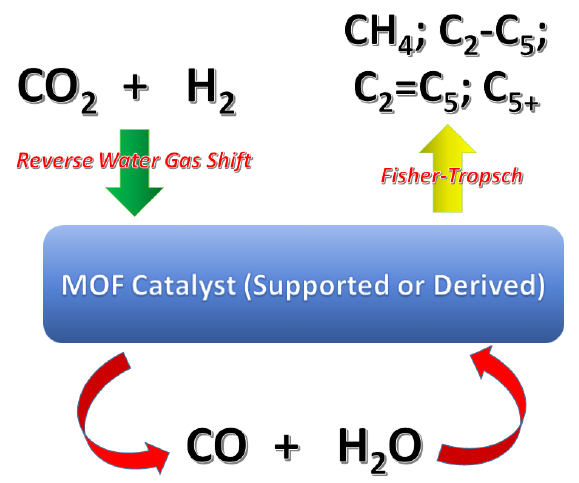
Figure 2. Scheme of the reactions to convert CO 2 in LHCF using MOFs as catalysts. Table 1. Summary of catalytic results for the hydrogenation of CO 2 with different supported